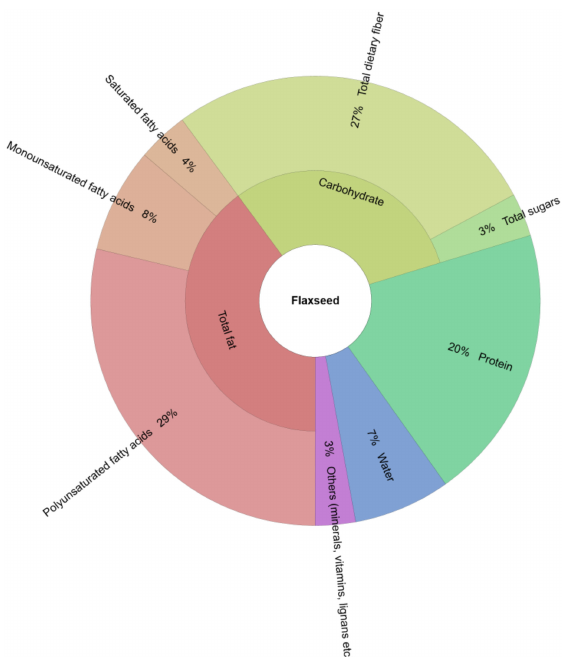
Figure 1. Krona chart showing the proximate composition of flaxseed. Source